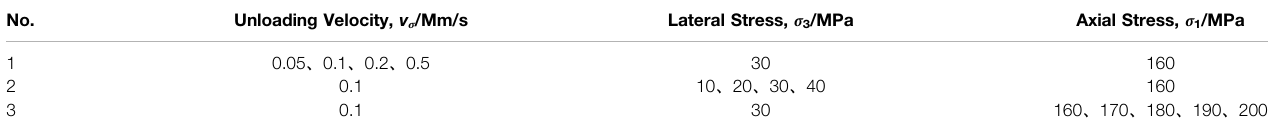
TABLE 2 | Unloading simulation schemes of the granite.